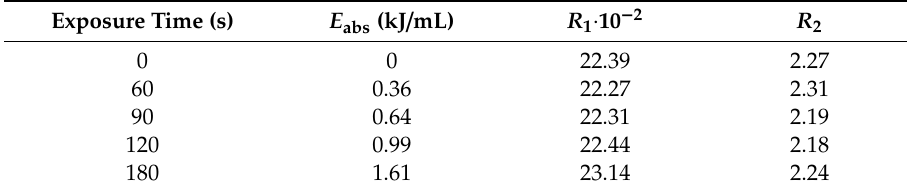
Table 2. Ratios R 1 and R 2 as a function of the absorbed MW